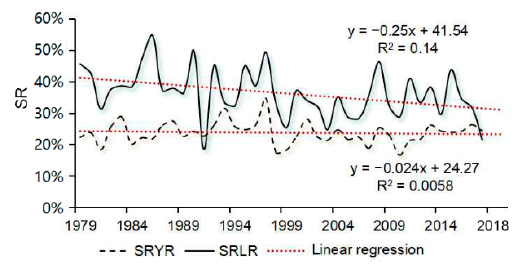
Figure 4. Variation trend for SR in SRLR and SRYR.